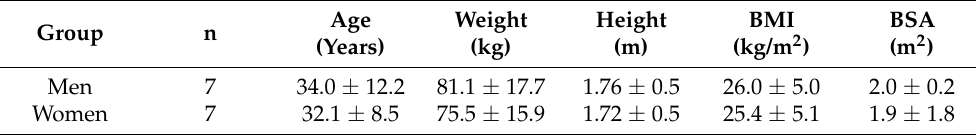
Table 1. Anthropometric characteristics (mean ± SD) of the participants in the two groups. Group